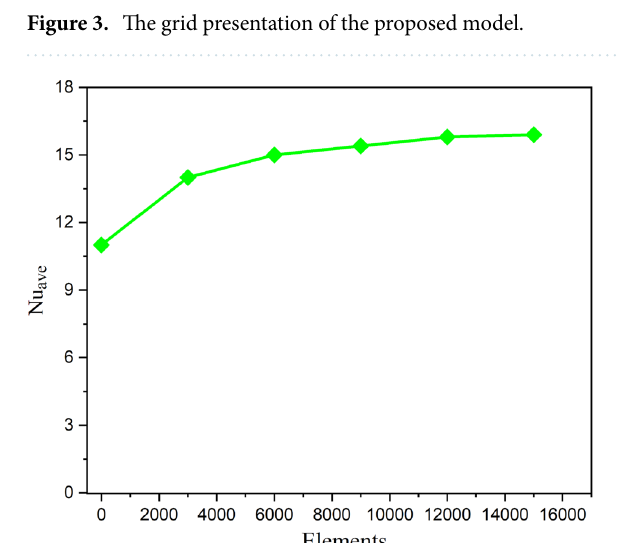
Figure 4. The grid test profile.